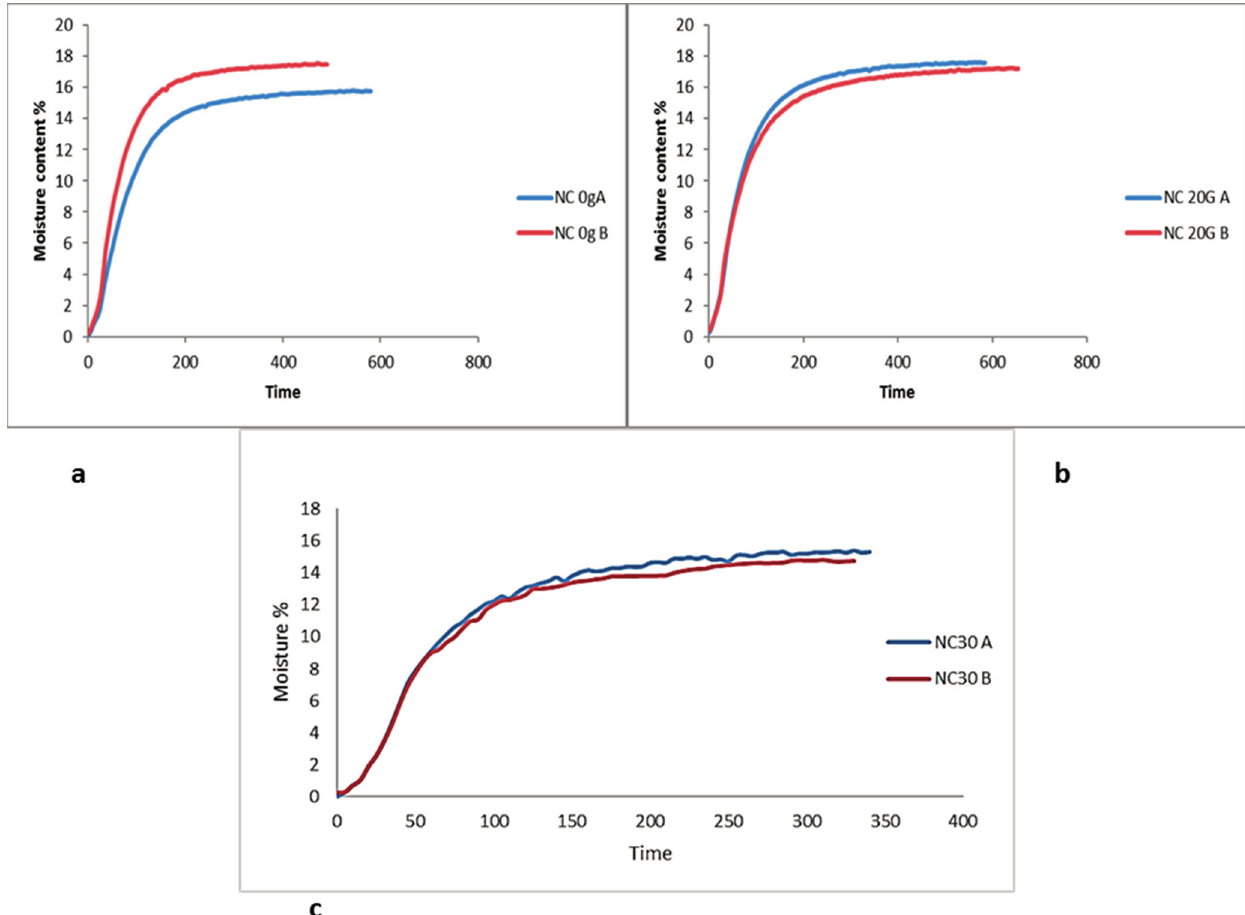
Figure 8. Moisture profile of fish scale biopolymer films containing ( a ) 0 g, ( b ) 20 g, and ( c ) 30 g